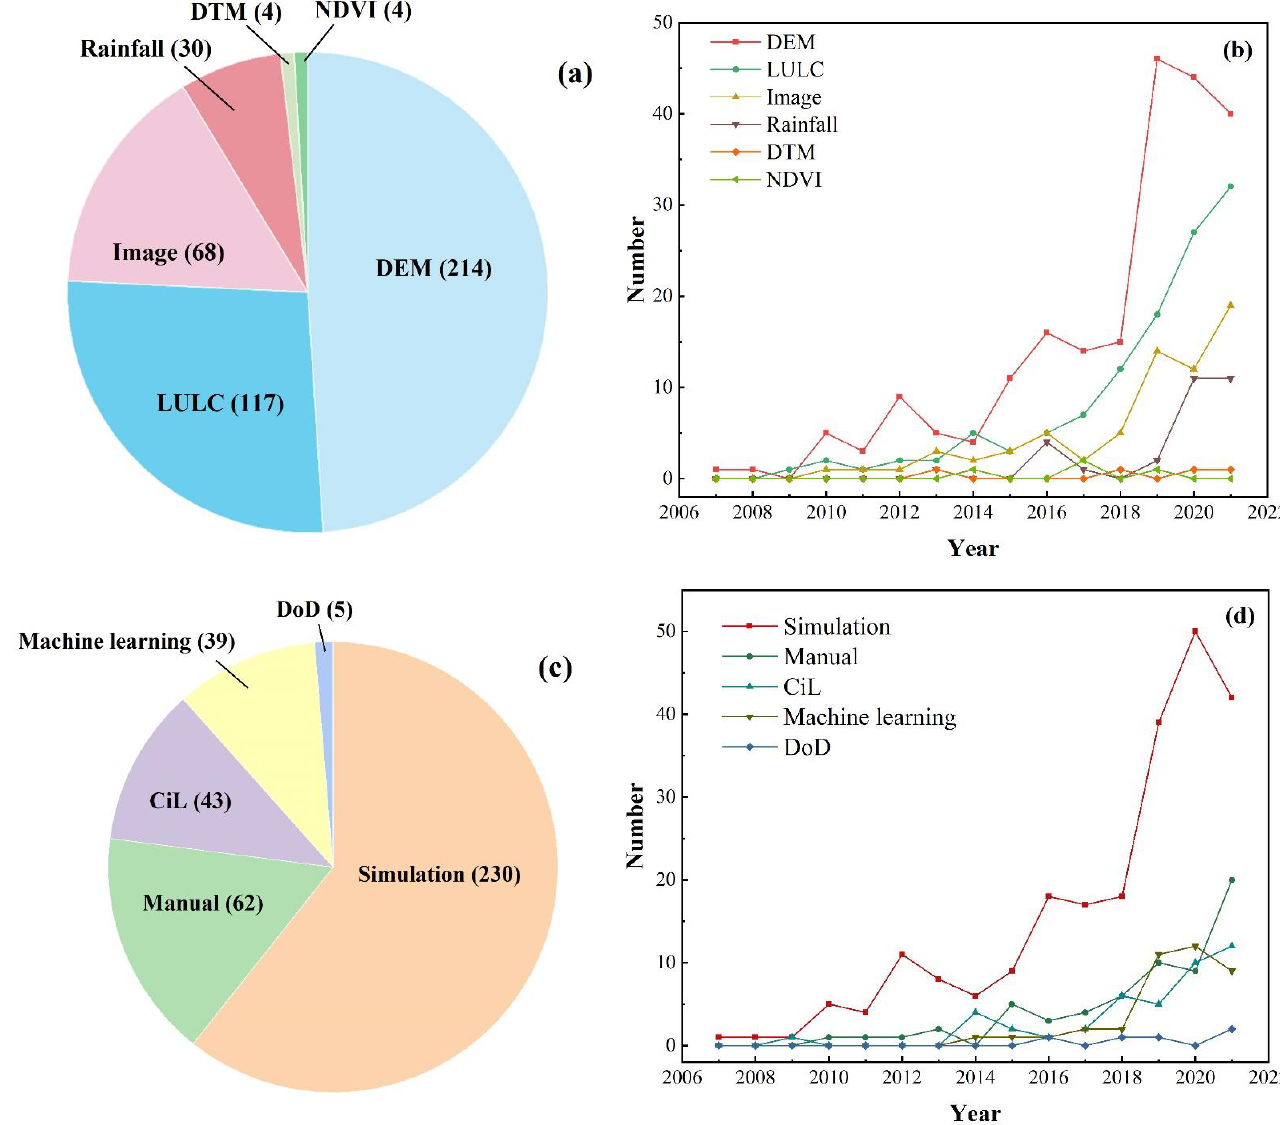
Figure 5. Remote sensing data type: the number of documents (a) all publication years; (b) each publication year. Remote sensing data analysis method: the number of documents (c) all publication years; (d) each publication year.